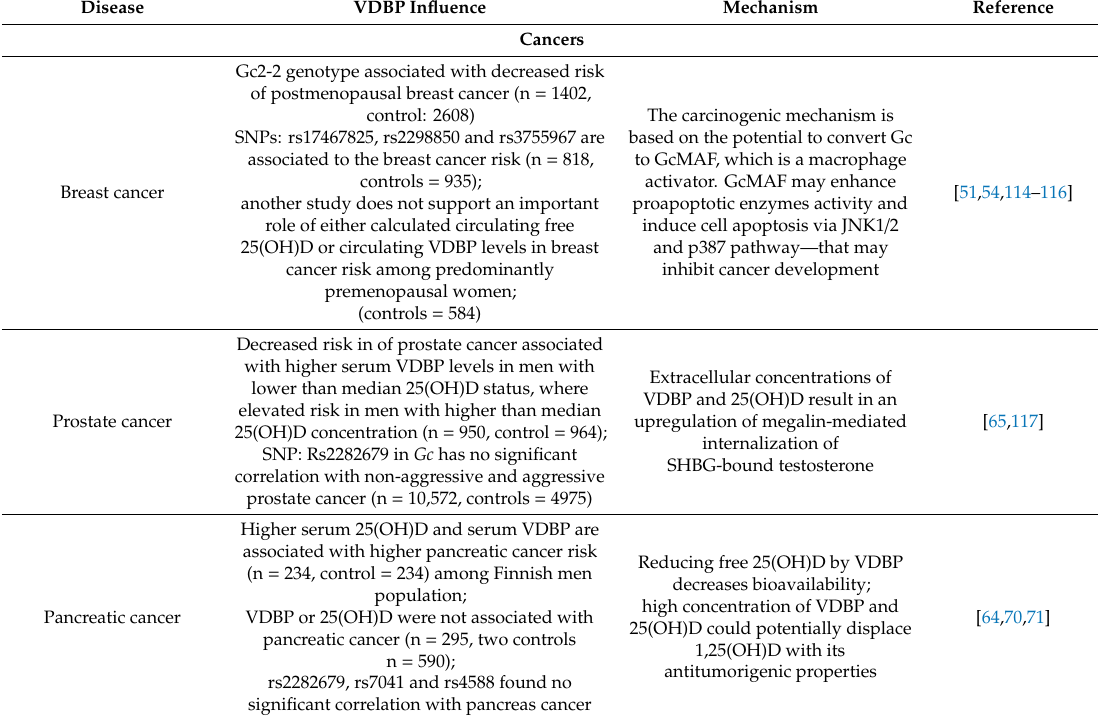
Table 2. Vitamin D binding protein (VDBP) and human